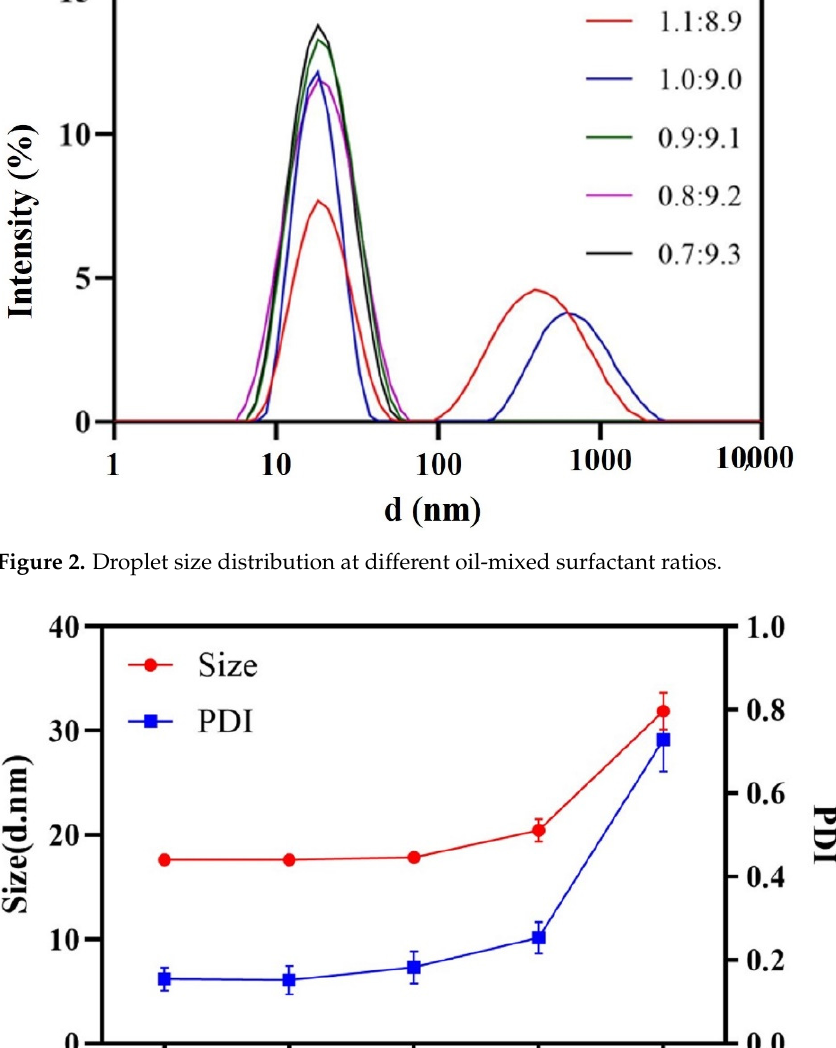
Figure 2. Droplet size distribution at different oil-mixed surfactant ratios.